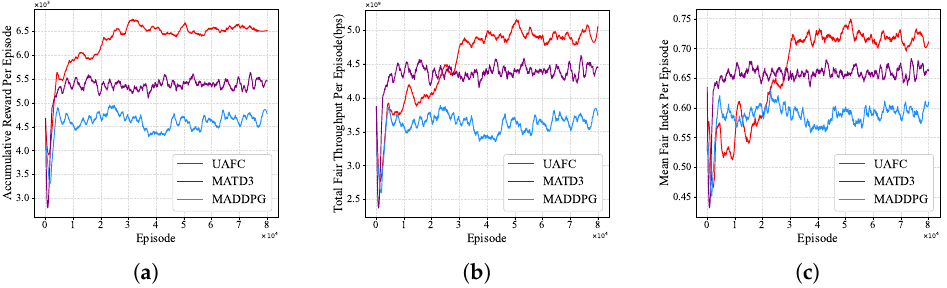
Figure 7. The training process of the UAFC, MATD3, and MADDPG algorithms. ( a ) Accumulative reward per episode. ( b ) Total fair throughput per episode. ( c ) Mean fair index per episode.